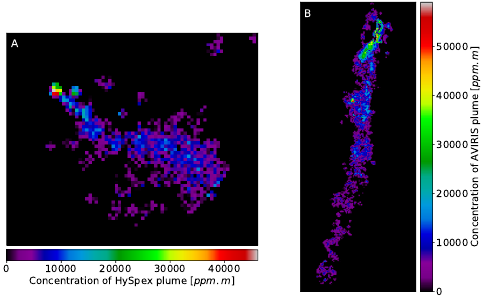
Figure 5. A : Zoom on the concentration map in ppm.m for the HySpex plume. B : Zoom on the concentration map in ppm.m